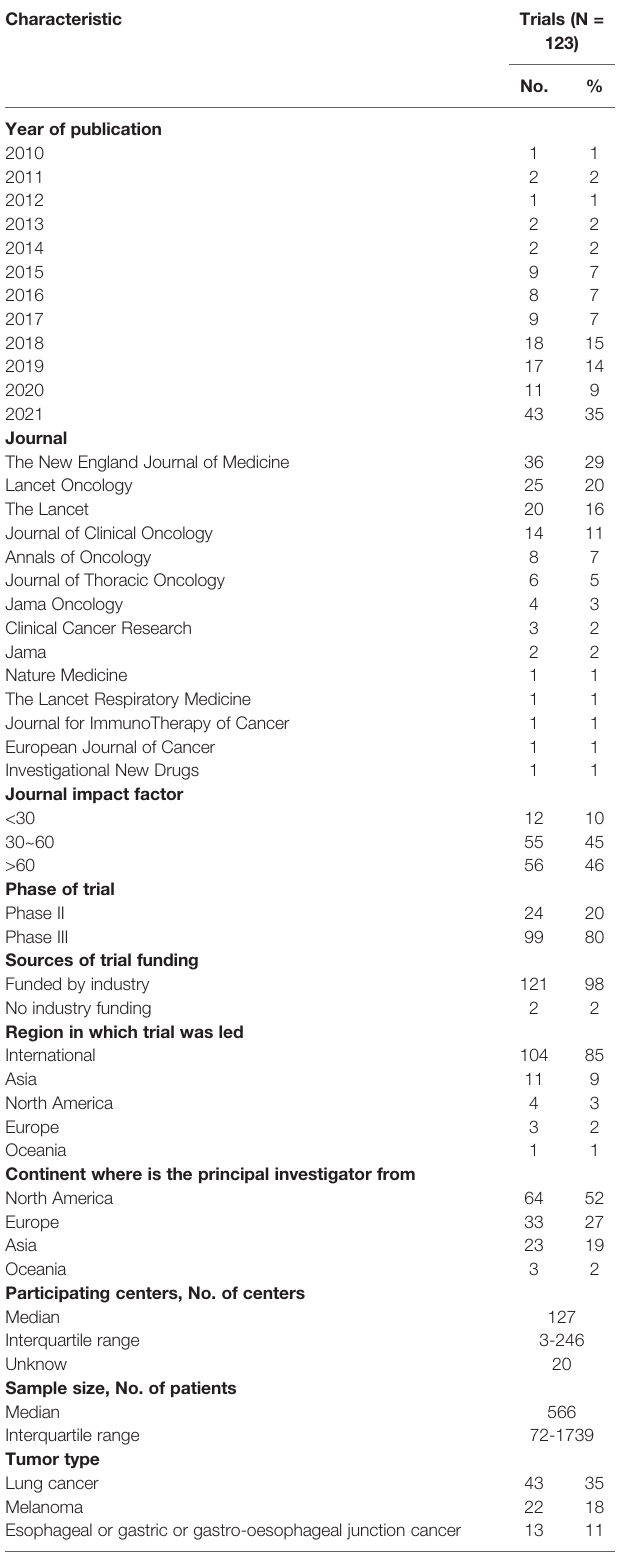
TABLE 2 | Characteristics of trials included in